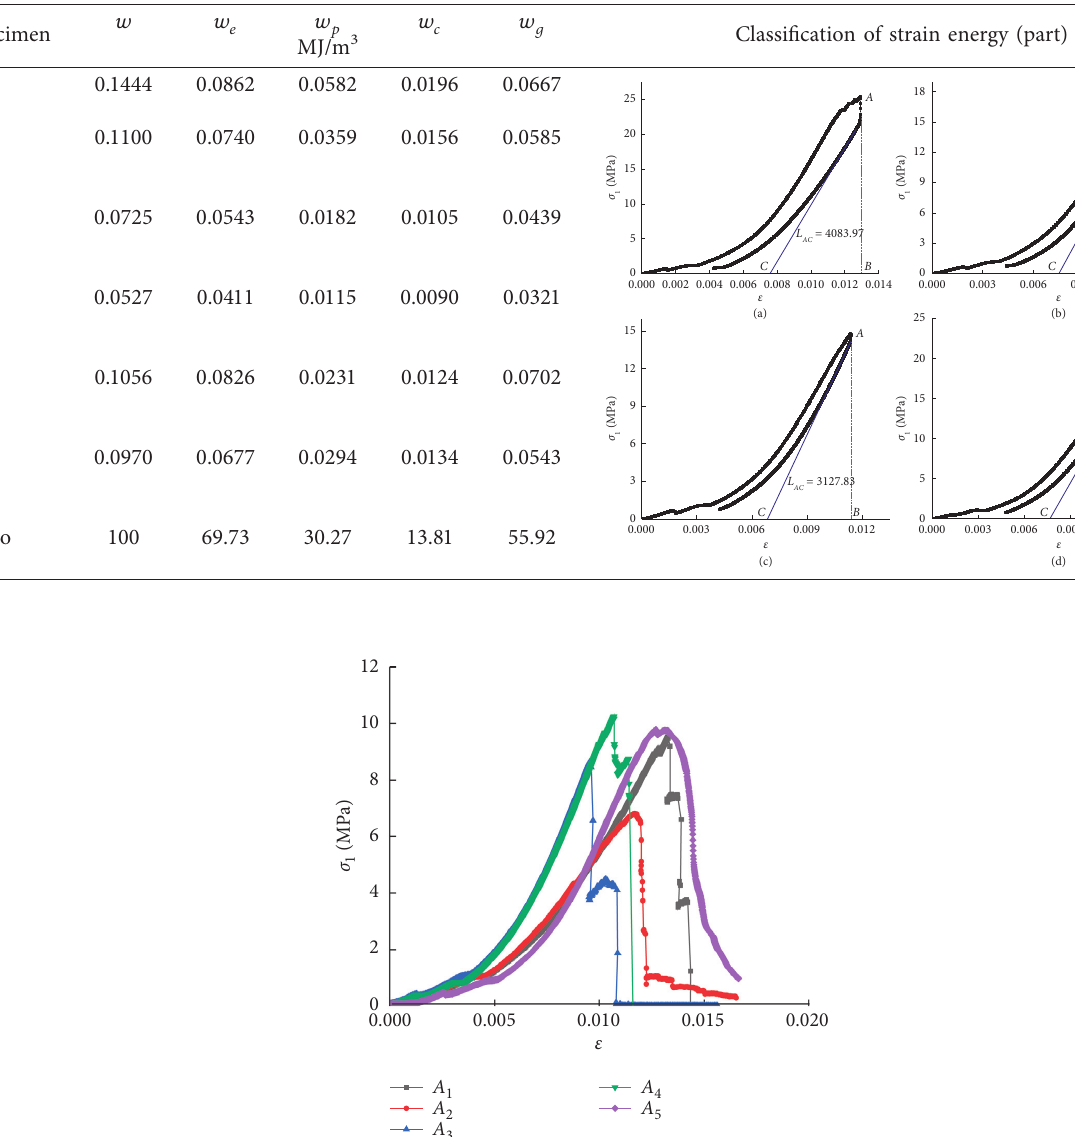
Table 2: Strain energy of coal samples from coal mine B.